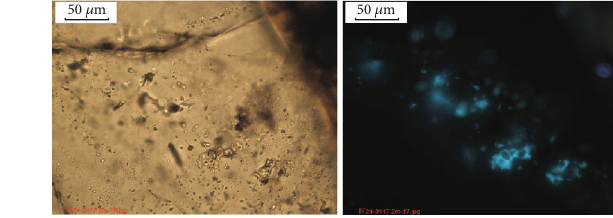
(c) Transparent colorless-gray gas-liquid hydrocarbon inclusion (condensate) with blue-green fl uorescence, 3397.37m, Sangonghe Formation, well Ke19; the left is under the plane-polarized light, and the right is under the UV-light